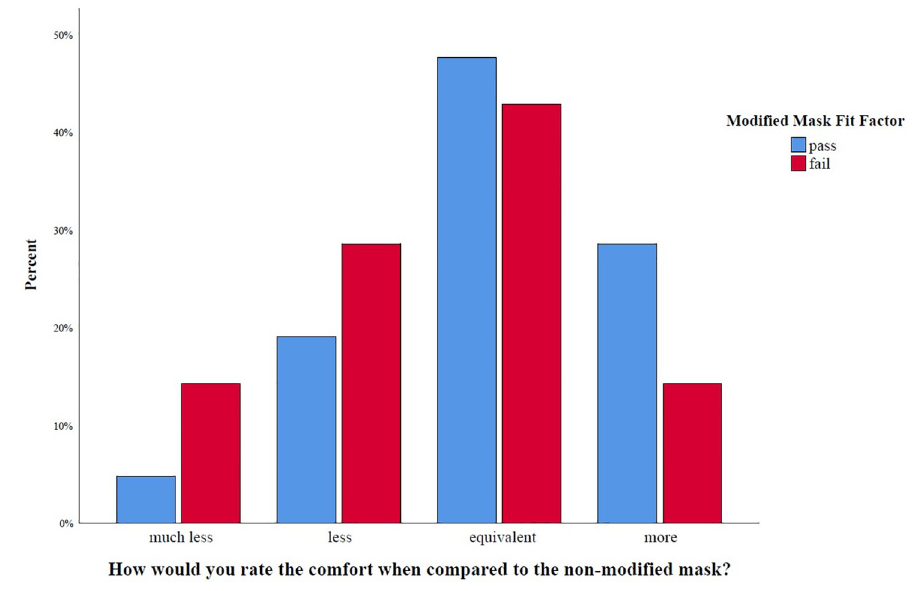
Fig 6. Subjective comfort of the modified mask compared to the surgical mask stratified by outcome.